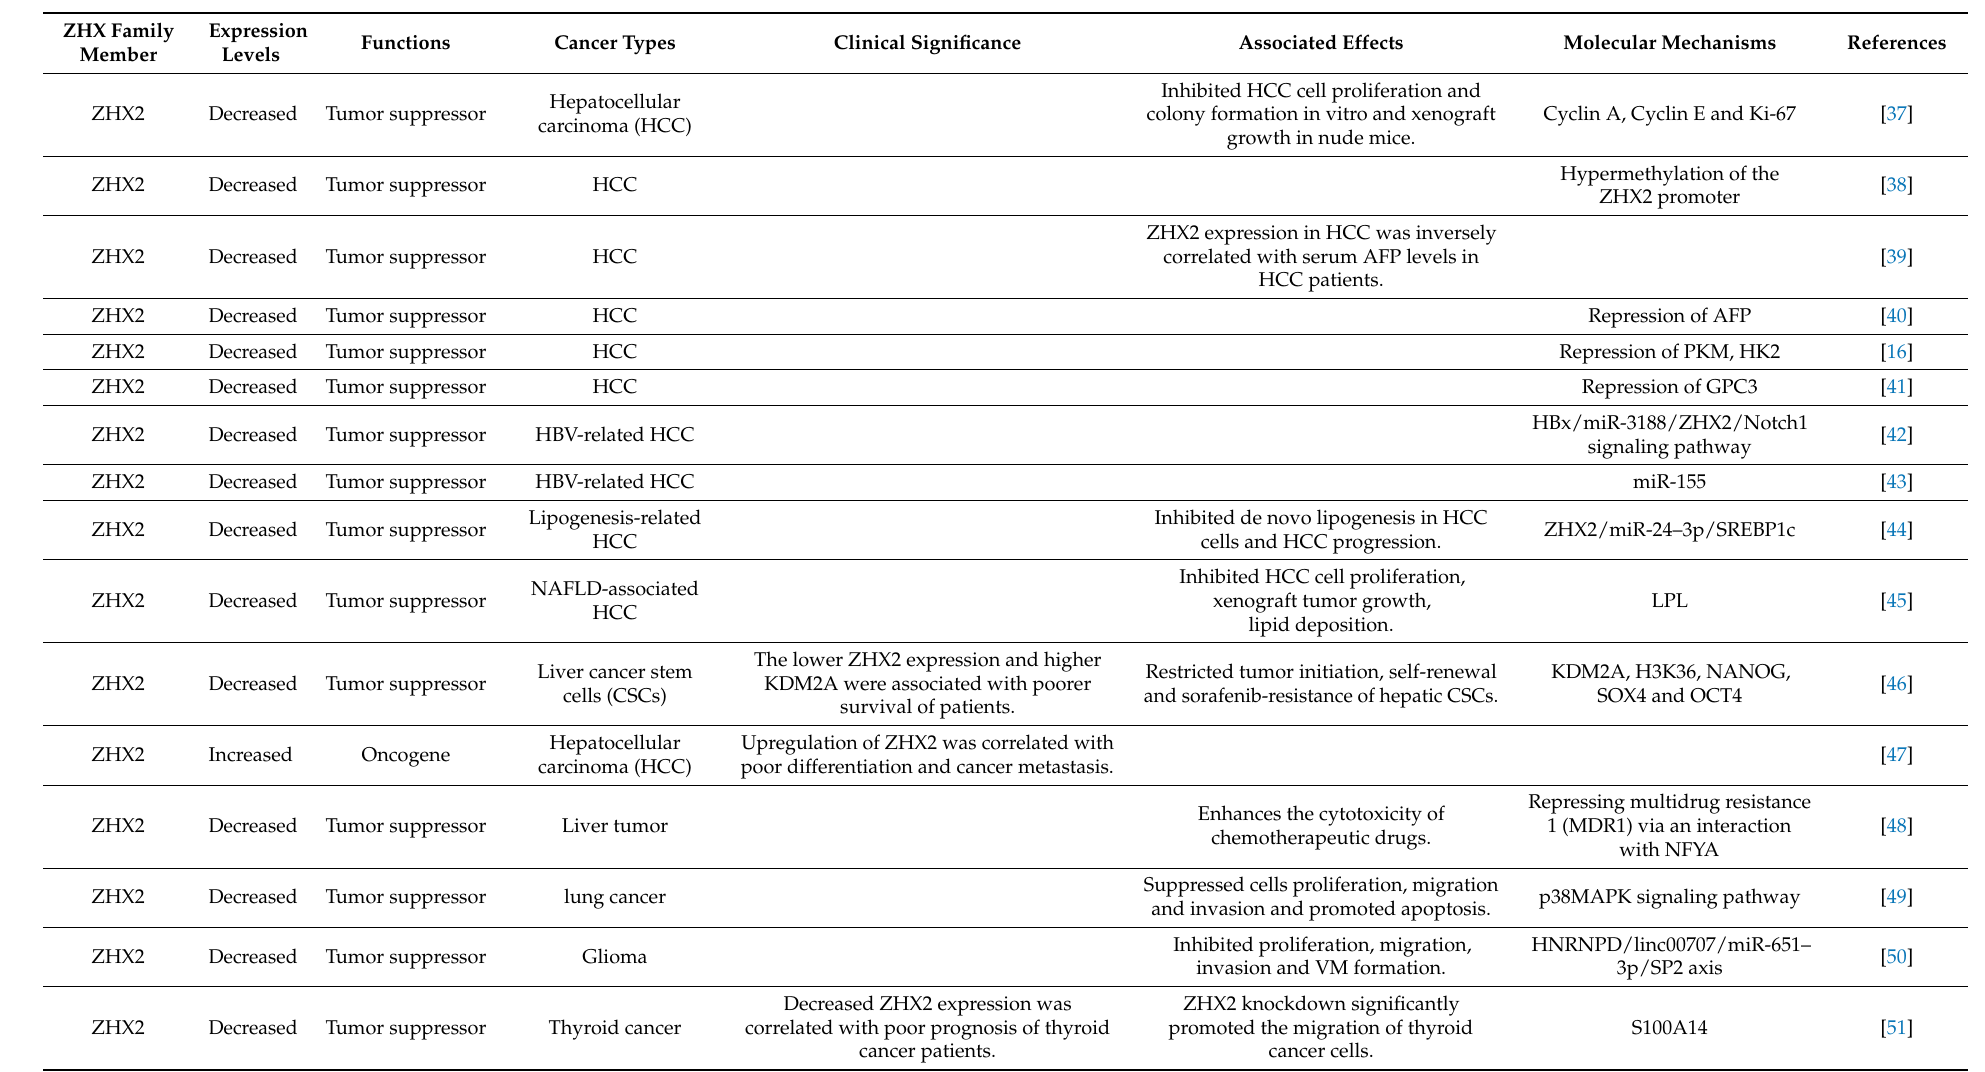
Table 2. Studies on ZHX2 expression, function, clinical significance, and molecular